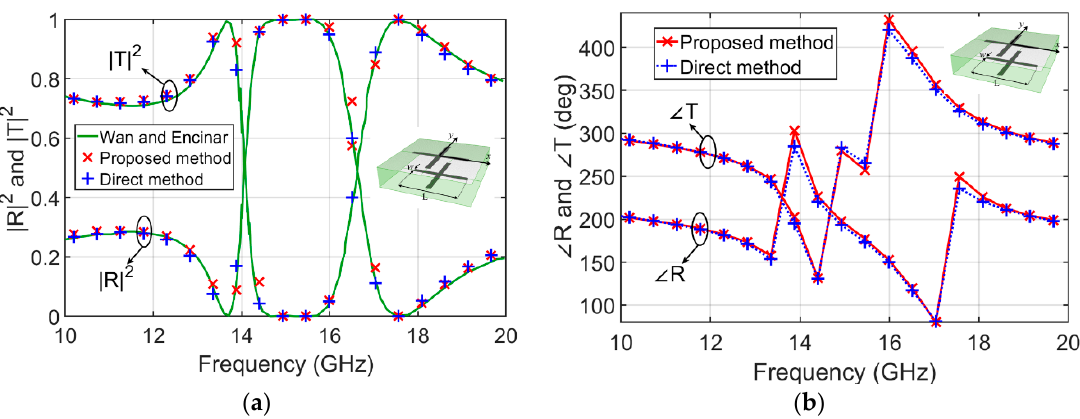
Figure 11. (a) Square of magnitude of the transmission coefficient, |T| 2 , and reflection coefficient, |R| 2 , of two stacked crosses printed on a single dielectric layer studied in Figure 4(b) of [36]. (b) shows the phases of the transmission and reflection coefficients .